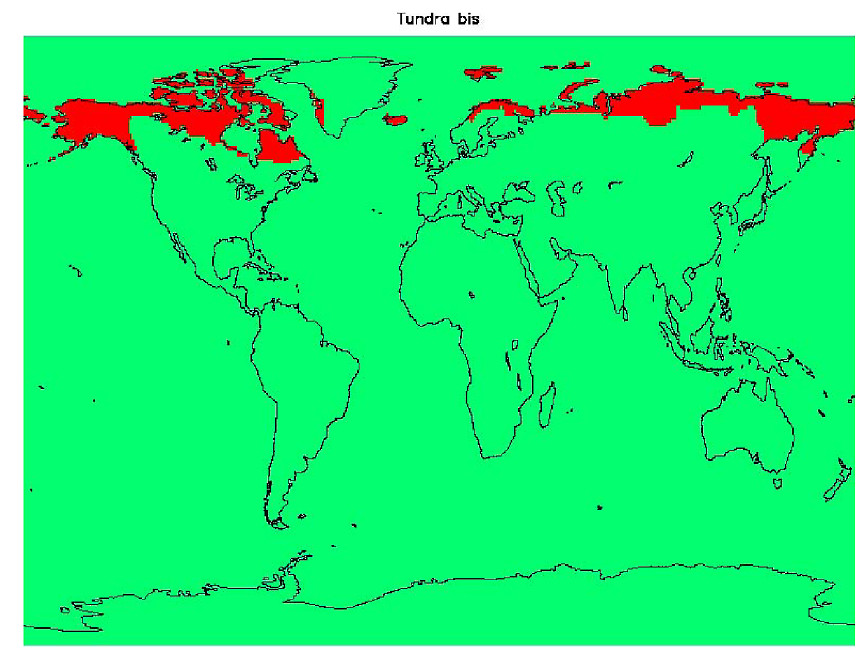
Fig. 1. The Arctic Tundra RECCAP